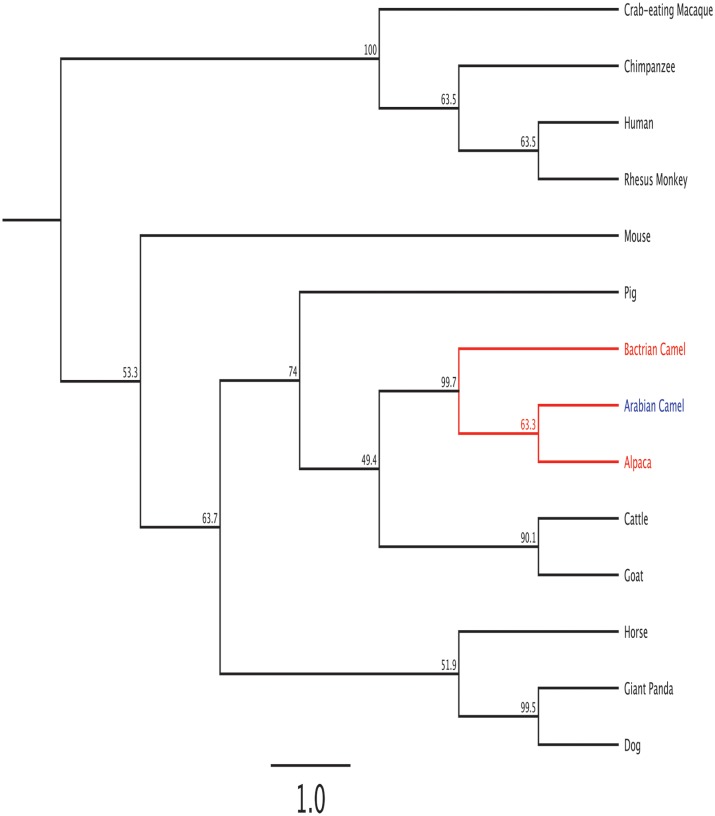
The phylogenetic tree shows the relationship of camel HSPB-1 protein and protein sequences from other species.Maximum likelihood tree based on complete coding sequences. Values at nodes are bootstrapping ≥ 49% obtained from 1000 resampling of the data.